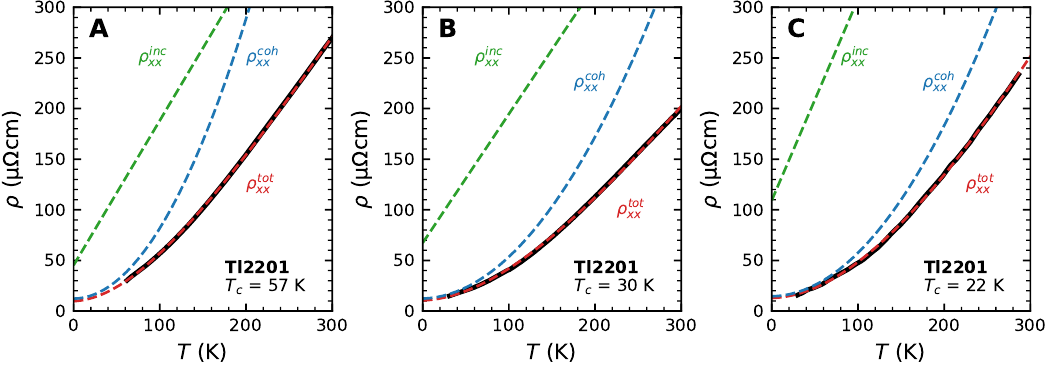
Figure 3: Parallel conductivity fits to the zero-field resistivities of OD Tl2201 with = 57 K [ 13 ] , B) : T = 30 K [ 13 ] and C) : T = 22 K [ 16 ] . Black lines represent A) : T c c c ( T ) contributions described the measured data, the blue dashed lines are the ρ coh xx ( T ) contributions described by by Eq. (21) and the green dashed lines are the ρ inc xx ( T ) as given by Eq. (20). The red dashed line represents the resultant fit to ρ tot xx Eq.